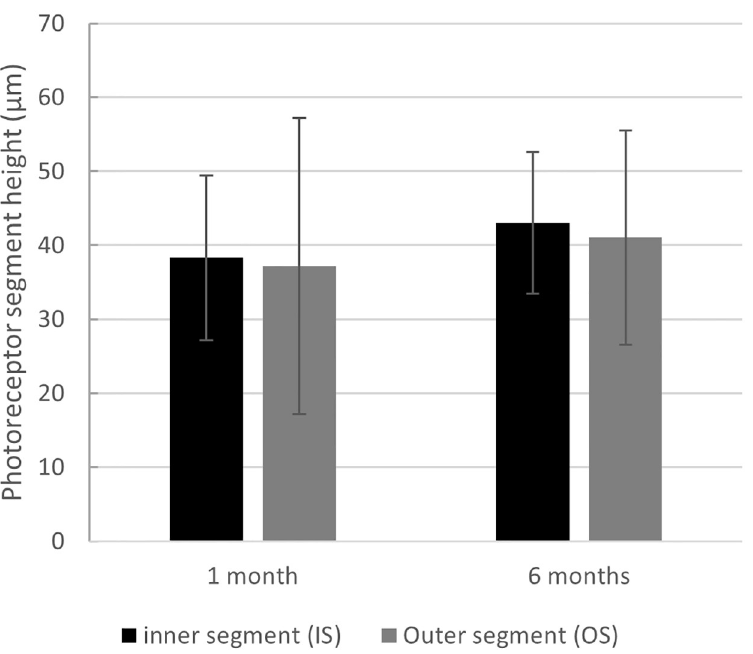
Fig 8. Inner and outer photoreceptor height changes. Change in subfoveal inner (IS) and outer (OS) photoreceptor segment height 1 and 6 months after vitrectomy with SF6 gas endotamponade for macula-involving primary retinal detachment. A slight increase in both IS and OS heights and no obvious changes in the IS/OS ratio may indicate a lack of clinical relevance (p > 0.05 for both). Whiskers indicate standard deviations.